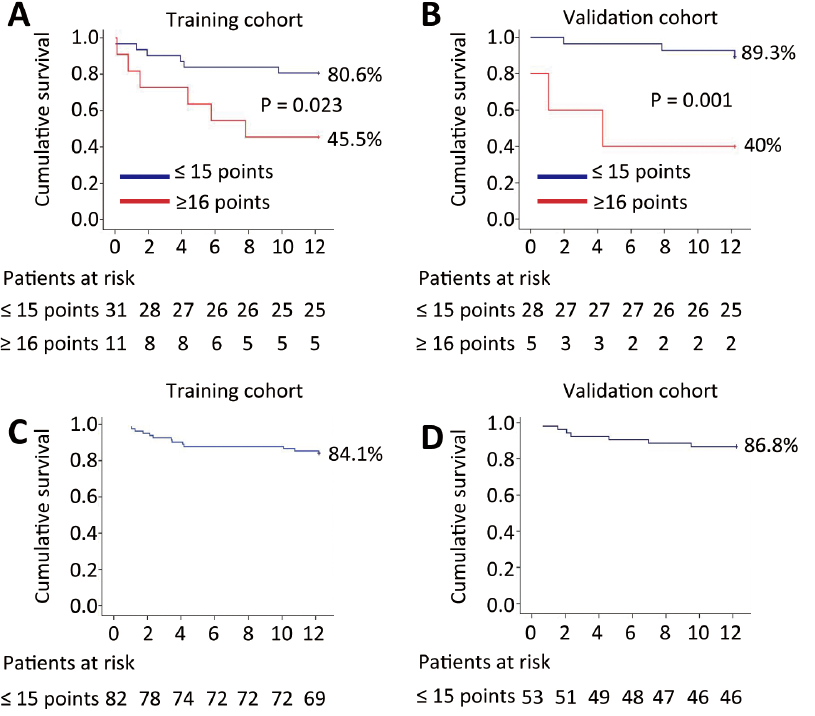
Figure 2. The one-year cumulative survival following the TIPS procedure of patients in the two Child-Na score groups ( # 15 points, $ 16 points) in the training cohort (A and C) and in the validation cohort (B and D). Note : All of the patients with serum Na levels